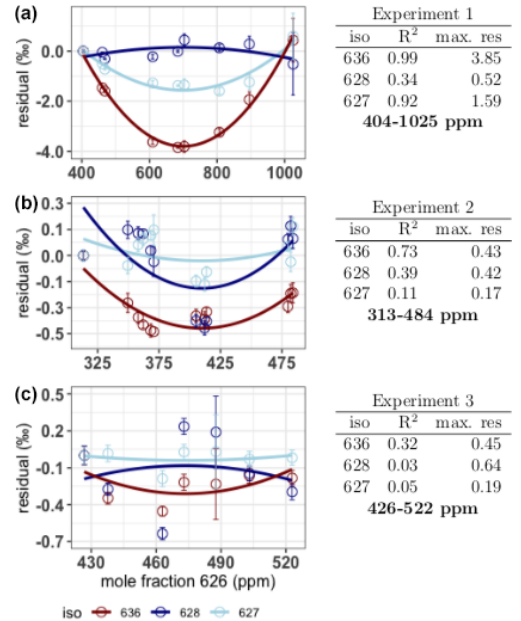
Figure 5. Residuals (expressed in ‰ relative to the measured amount fraction) of the linear fit of the rare isotopologue abun- dances as a function of the X 626 and the quadratic fit on the resid- uals. From top to bottom: experiment 1, experiment 2 and experi- ment 3. The colors red, dark blue and light blue are used for the iso- topologues 636, 628 and 627 respectively. Error bars are the com- bined standard deviations of the 626 and rare isotopologue measure- ments. Per isotopologue the R 2 of the quadratic fit on the residuals is indicated in the tables on the right, as well as the maximum resid- ual (in ‰) on the linear fit of the rare isotopologue as a function of the X 626 .